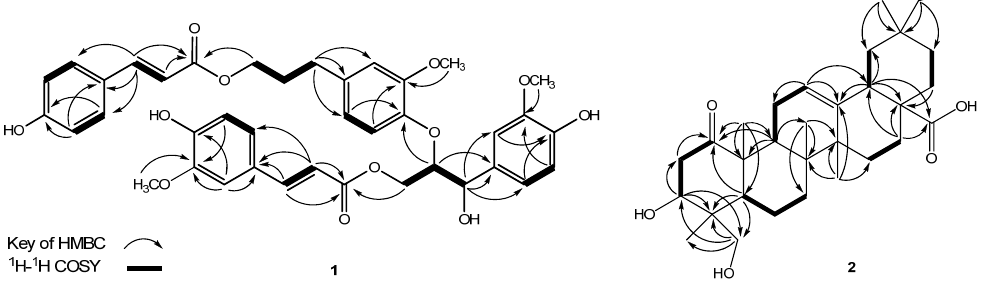
HMBC correlations between the proton at δ and 47.6 (C-5), between δ 41.0 (C-19), 36.7 (C-20), 33.0 (C-21) and 19.5 (C-30), suggested that the two secondary hydroxy groups were connected to C-23 and C-29,